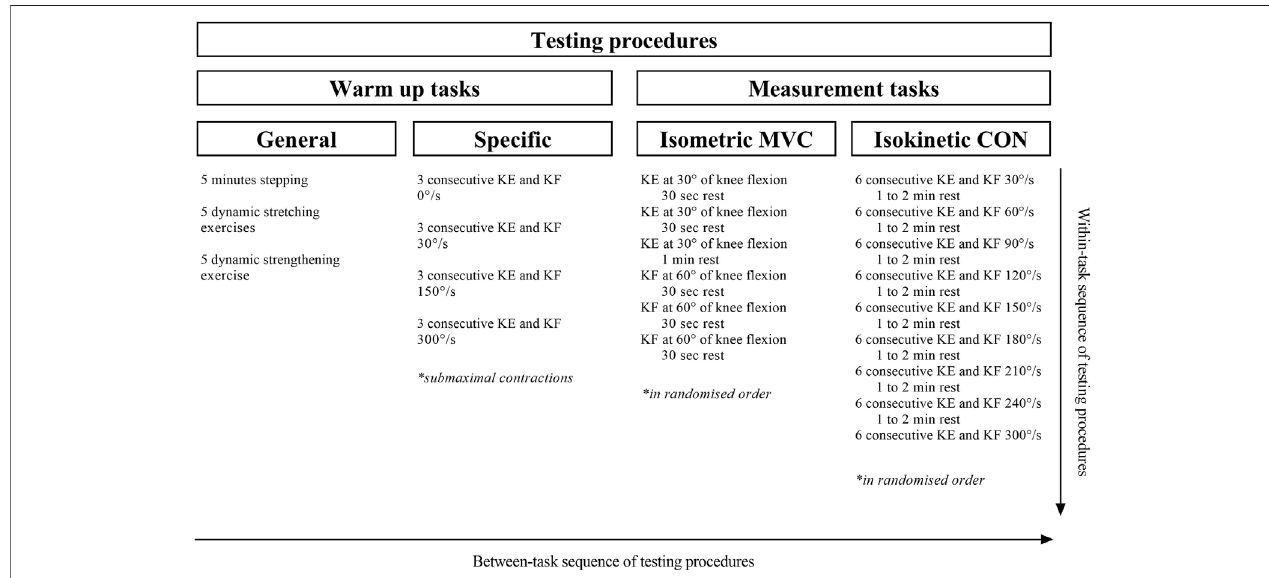
FIGURE 1 | Graphical presentation of experimental design and measurement procedures of the study. KF, knee fl exion; KE, knee extension; F, force; ISO, isometric; POLY, polynomial; LIN, linear; F 0 , maximal theoretical force; V, velocity; N, Newtons; kg, kilograms; m, meters; s, seconds.